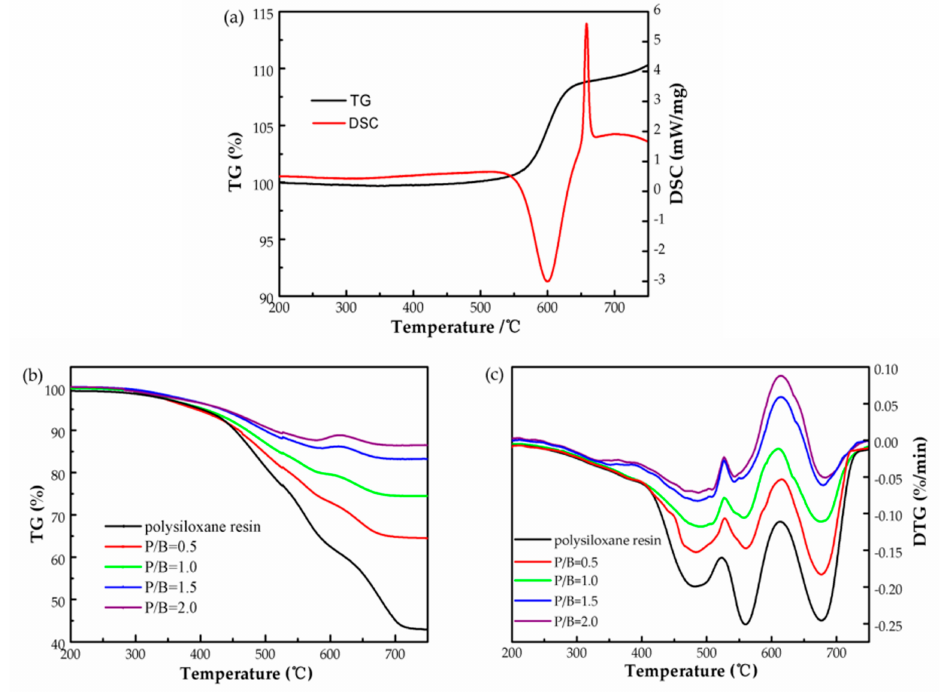
Figure 2. ( a ) TG and DSC curves of aluminum pigments; ( b ) TG curves of polysiloxane resin and polysiloxane/Al coatings with different P/B ratios (the mass ratio of pigment to binder); ( c ) DTG curves of polysiloxane resin and polysiloxane/Al